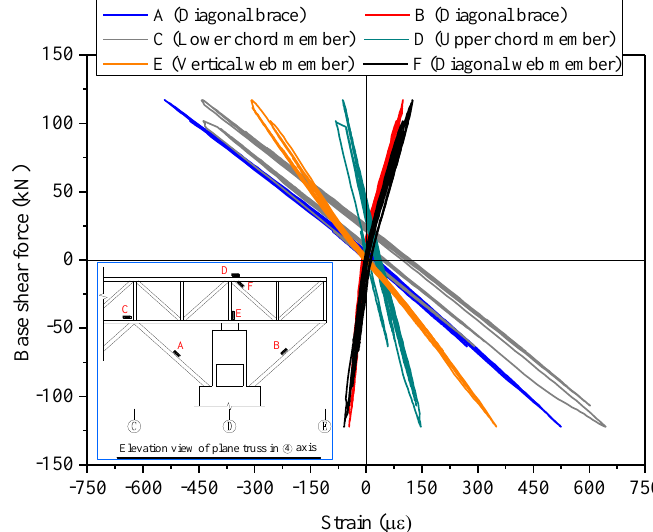
Table 3. Cracking details of the column C1 under pseudo-dynamic tests (PDTs).